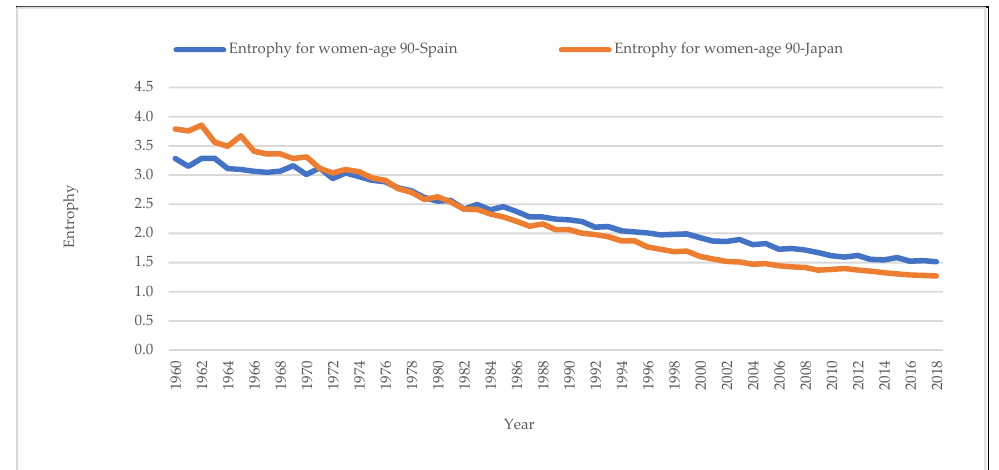
Figure 12. Entropy evolution of the female population at 90 over calendar years. Source: authors.